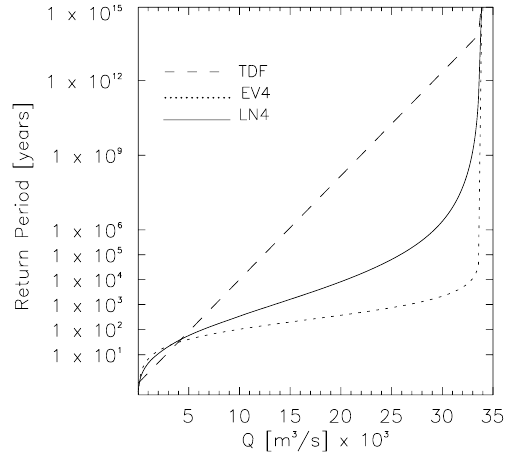
Fig. 3. TDF, EV4 and LN4 different behaviour approaching the same upper limit. Parameters for each distribution function are the same than in Fig. 2 (central): the case study data with the ML-PG estimation